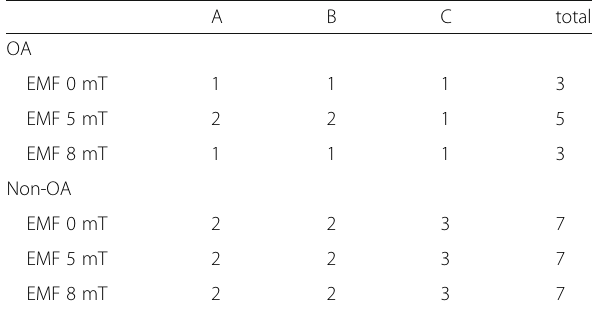
Three categories were evaluated: A intensity of safranin-O staining, B distance between cells/amount of matrix that was accumulated and C cell morphologies